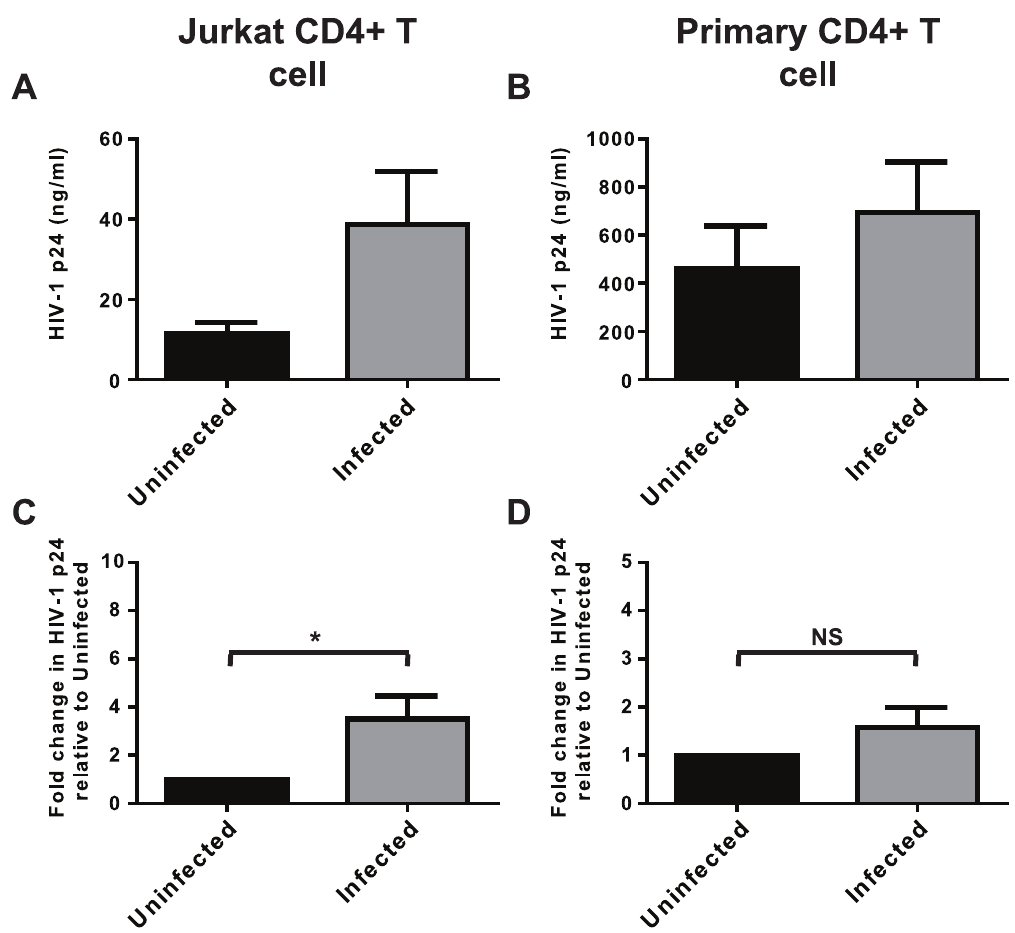
Figure 1. N.gonorrhoeae stimulates HIV-1 replication in CD4 + T cells. HIV-1-infected Jurkat CD4 + T cells (A and C) or T cell receptor crosslinking antibody-activated primary CD4 + T cells (B and D) were co-infected with N. gonorrhoeae at a MOI of 10 (Infected) or left infected with